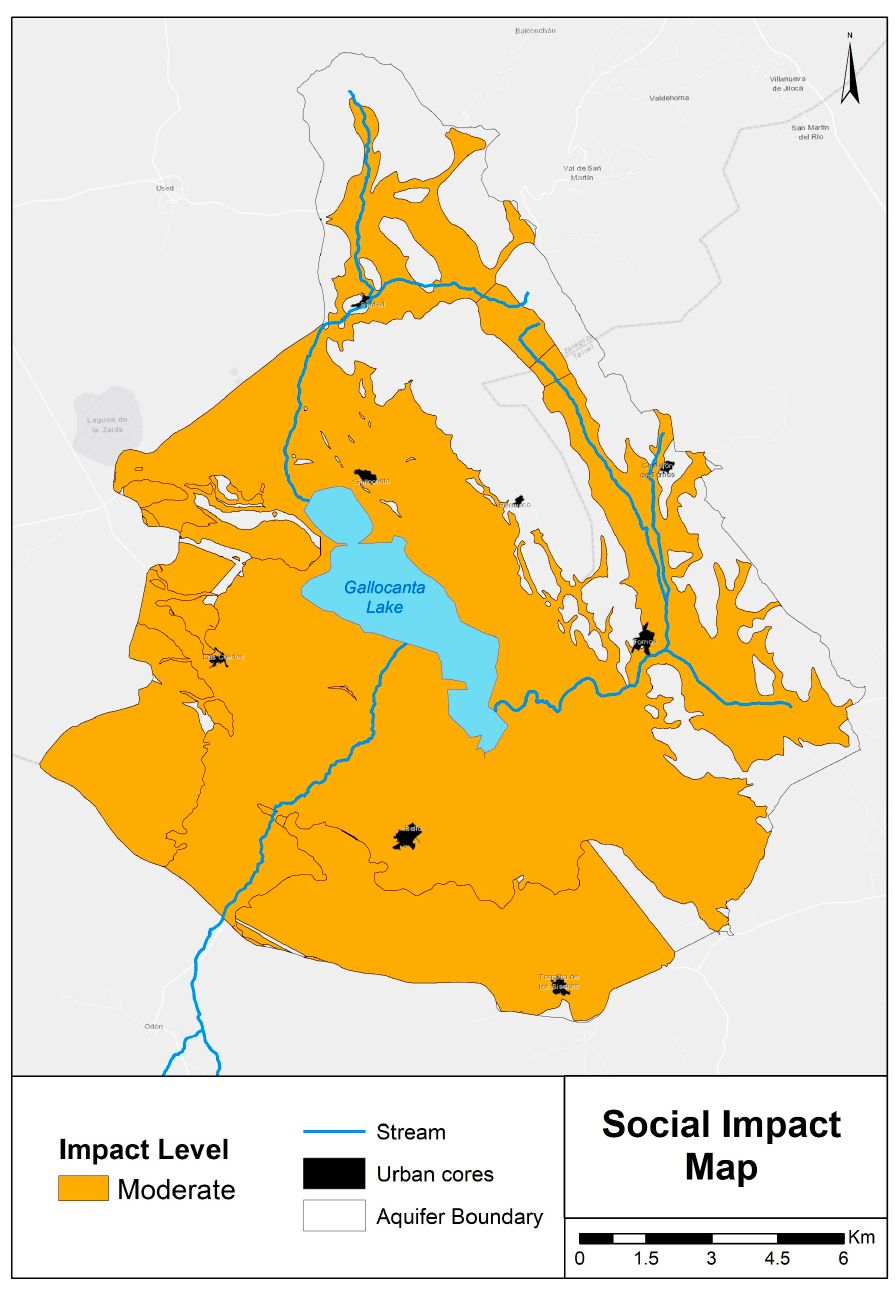
Figure 6. Impact